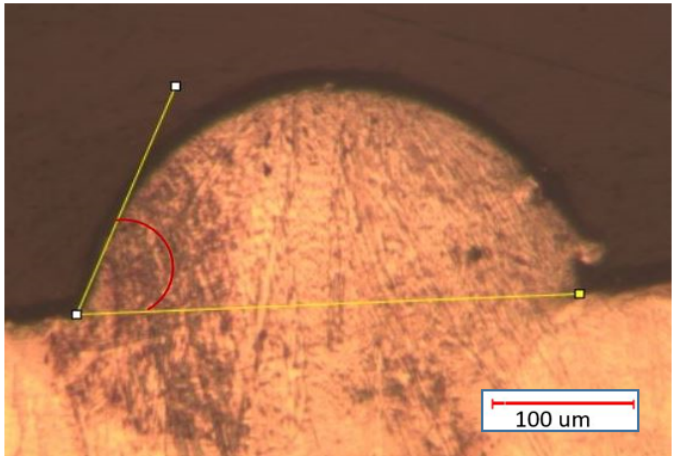
Figure 1. Contact angle measurement.